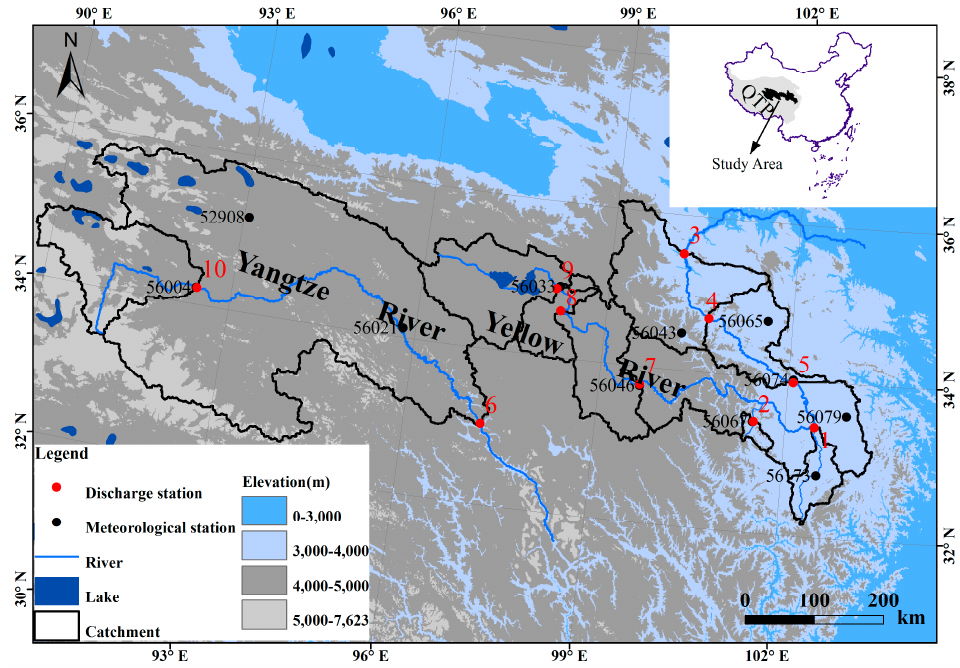
Figure 1. Location of the Qinghai-Tibetan Plateau (QTP) and 10 catchments analyzed in this study. Codes are listed in Table 1. Discharge stations are listed with increased permafrost coverage. Included are the 11 meteorological stations with station codes from the China Meteorological Administration (Table 2).